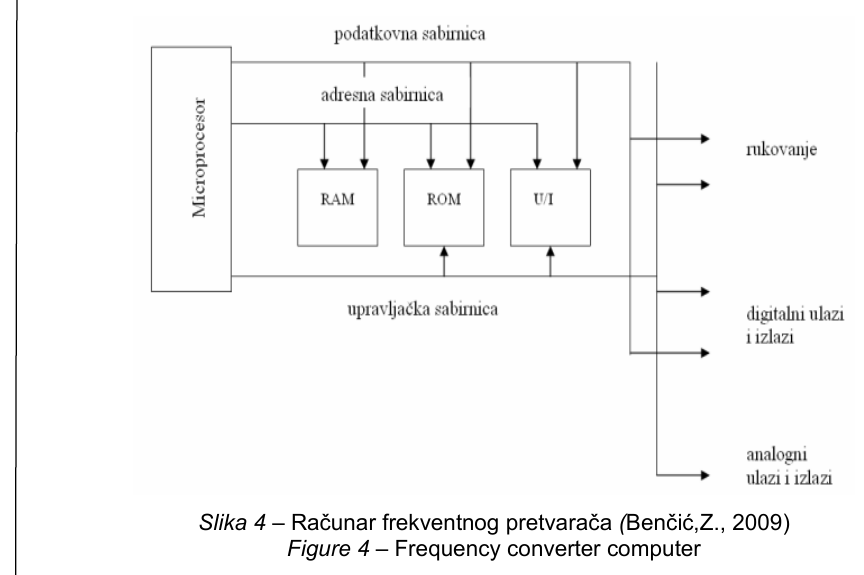
Figure 4 – Frequency converter